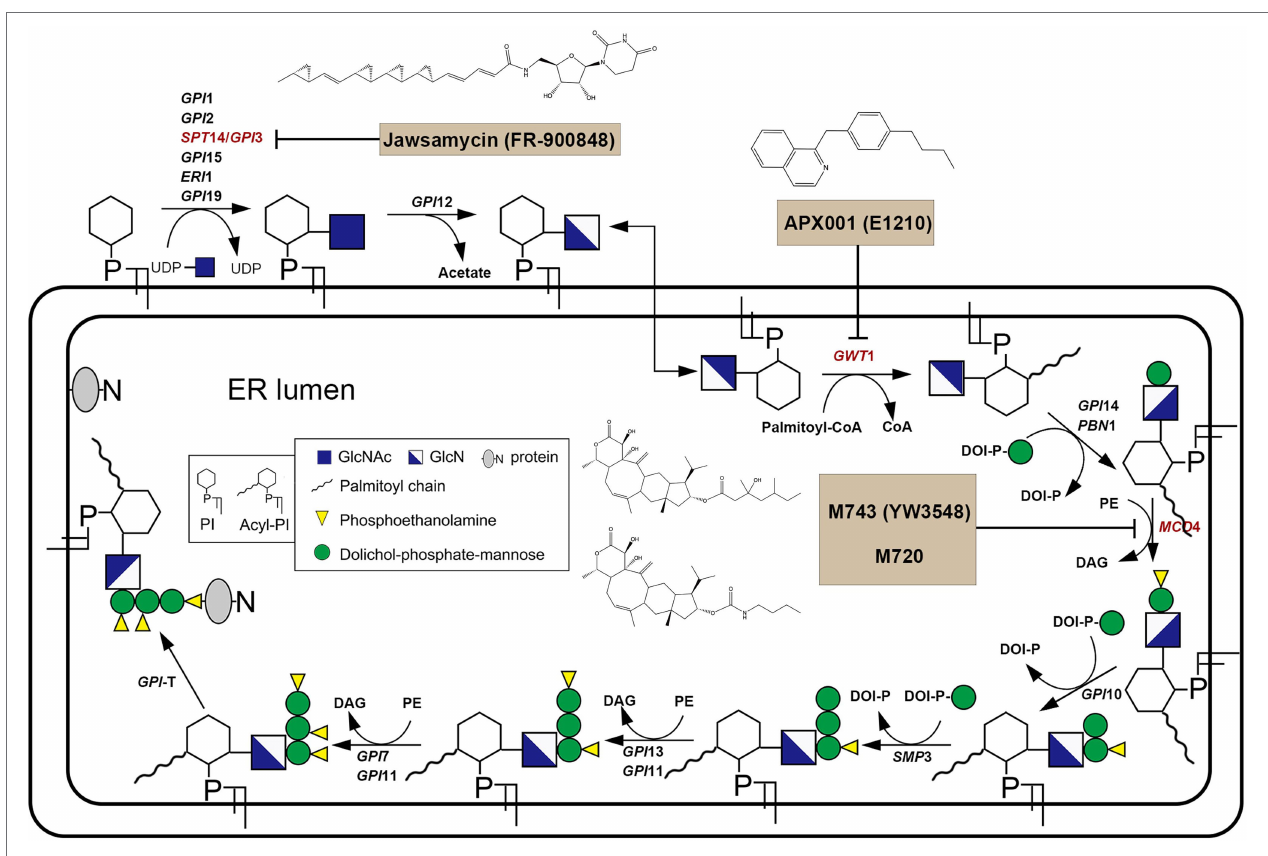
FIGURE 2 | Overview of GPI biosynthesis in yeast.